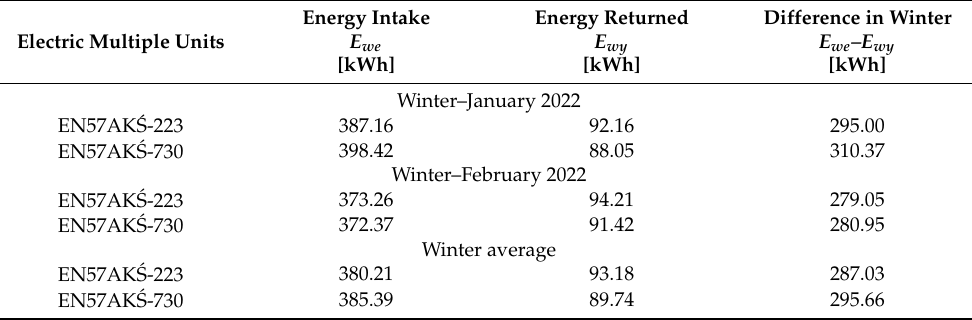
Table 8. Summary of energy intake and return during the winter